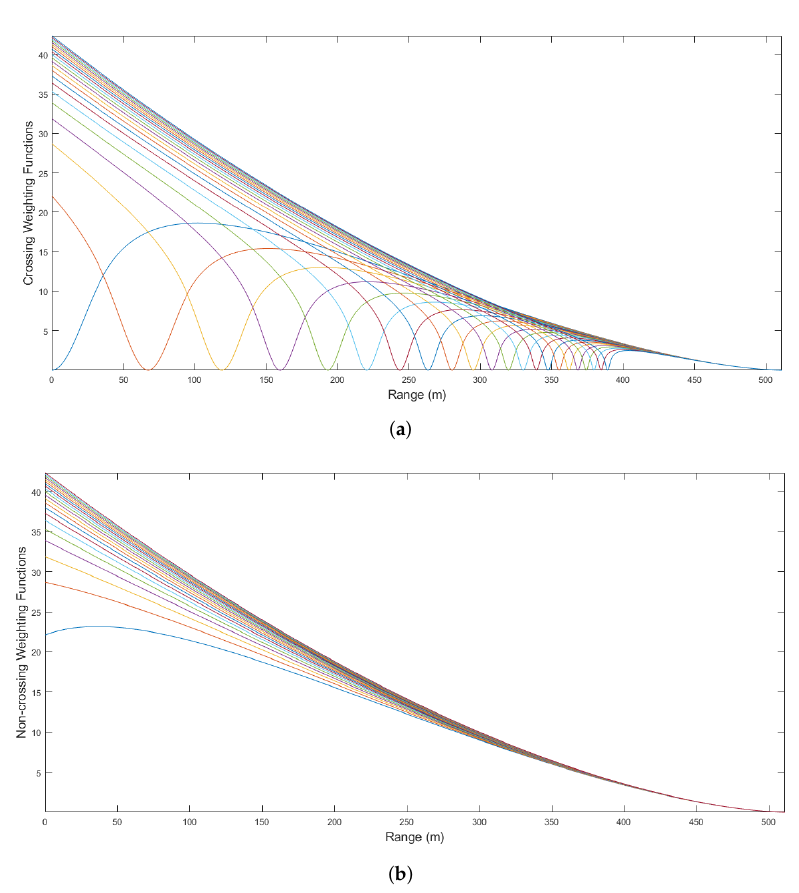
Figure 6. ( a ) The 22 crossing weighting functions and ( b ) the 21 non-crossing weighting functions. Each of the weighting functions drops to zero at the source end of the path ( z = L ), which implies the turbulence near the laser beacons has little to no effect on the measured wavefront tilts [5]. The crossing weighting functions each have a notch along the path where their two sensing paths cross and the tilts